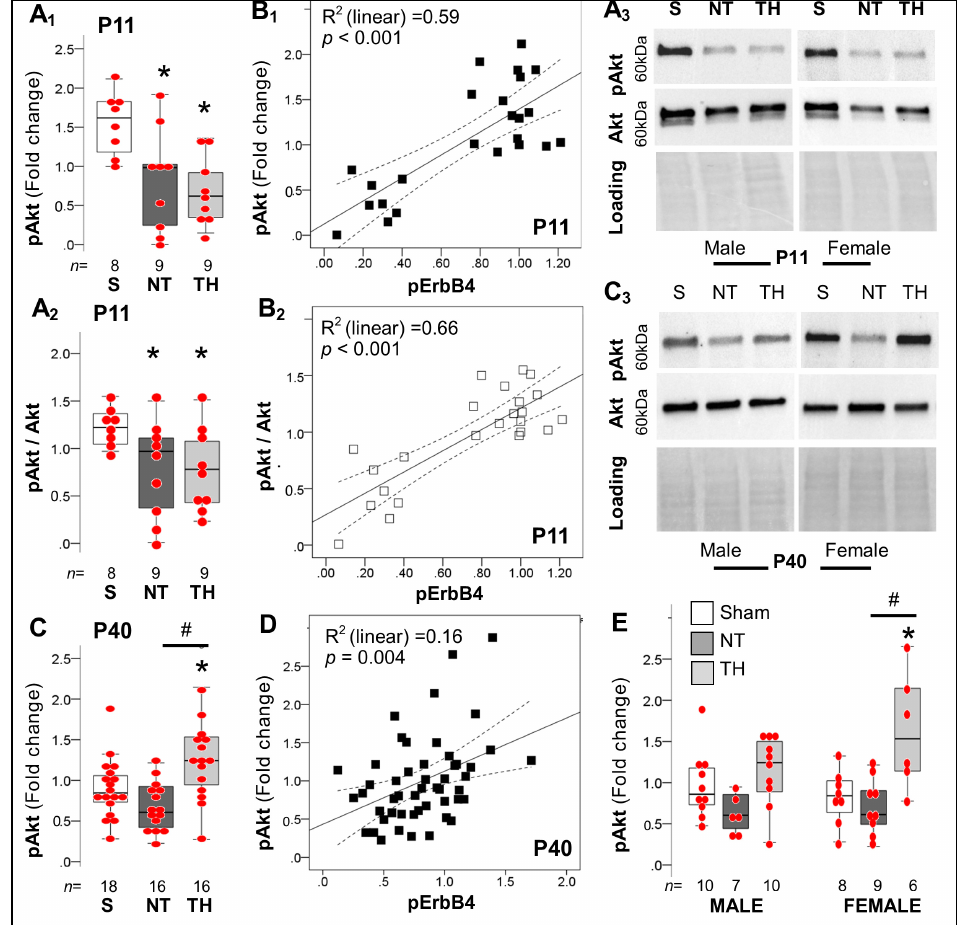
Figure 7. Alterations in downstream Akt phosphorylation in hippocampus after neonatal HI. ( A ) Phosphorylation of Akt was decreased in hippocampi from NT ( p = 0.02) and in TH mice ( p = 0.005) compared to sham at P11 (KW p < 0.01, A 1 ), resulting in decrease ratio of Ser 473 phospho- rylated to total Akt ( A 2 ). Representative blots show phosphorylated Ser 473 and total Akt at 60 kDa with Ponceau S as loading control. ( B ) Deficits in pAKT ( B 1 ) and the pAkt/ Akt ratio ( B 2 ) linearly correlated with the degree of Y1162 ErbB4 phosphorylation at P11. ( C ) At P40, HI injury did not produce significant deficits in AKT phosphorylation, but TH increased pAKT levels compared to sham and NT mice, respectively (KW p = 0.004). ( D ) ErbB4 phosphorylation weakly predicted the changes in pAkt at P40 ( p = 0.004). ( E ) Sex stratification demonstrated increased pAkt most robustly in TH female mice. Quantifications are shown as hybrid box and whisker with vertical dot plots. *, p < 0.05 vs. sham; and # , p < 0.05 vs. NT (Dunn-Bonferroni post-hoc test for Kruskal Wallis ANOVA; n shown under each